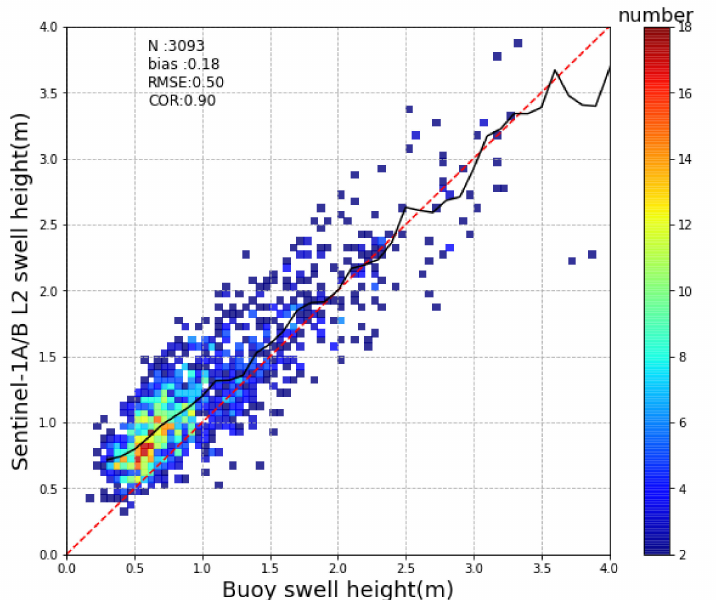
Figure 10. Intercomparisons of the partitioned swell heights for S-1A/B versus buoy, from match-ups of S1L2Buoy, as defined in Table 1. Colors denote the number of data points within 0.1 m × 0.1 m bins. The superposed solid lines provide the median y -axis value for each x -axis bin.